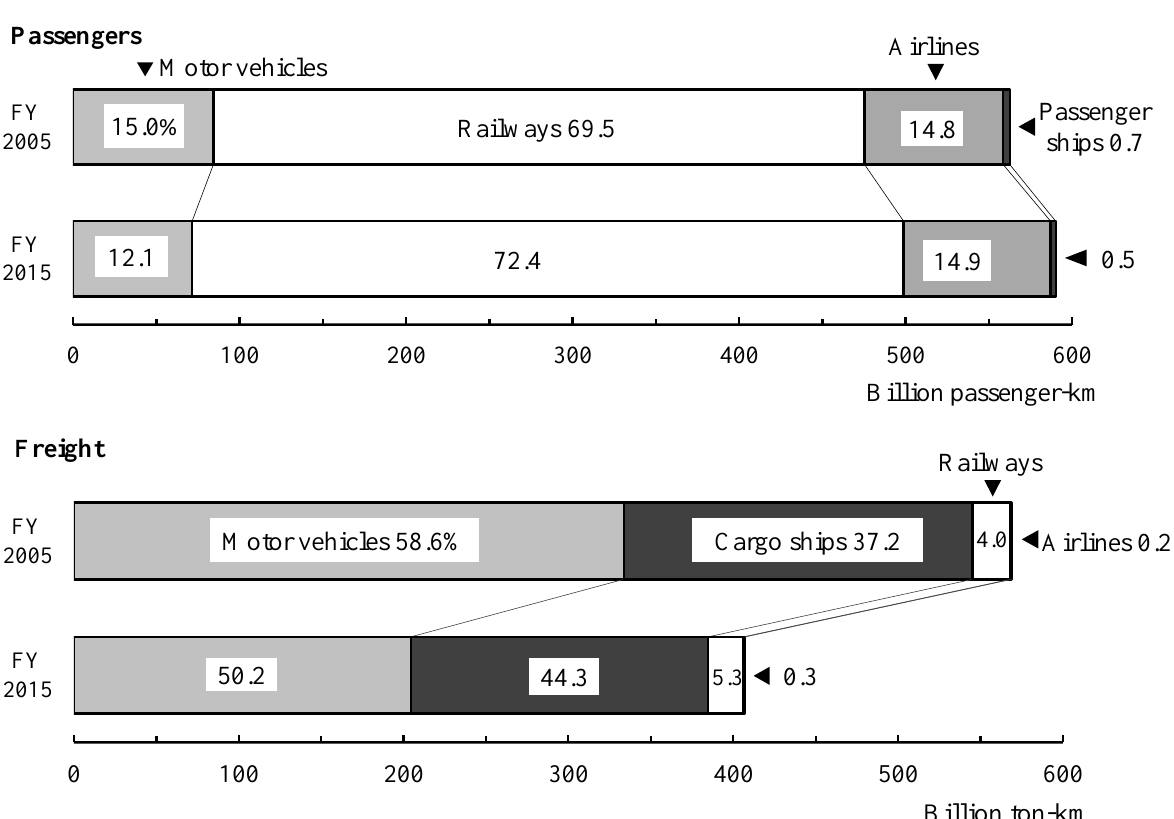
Composition of Domestic